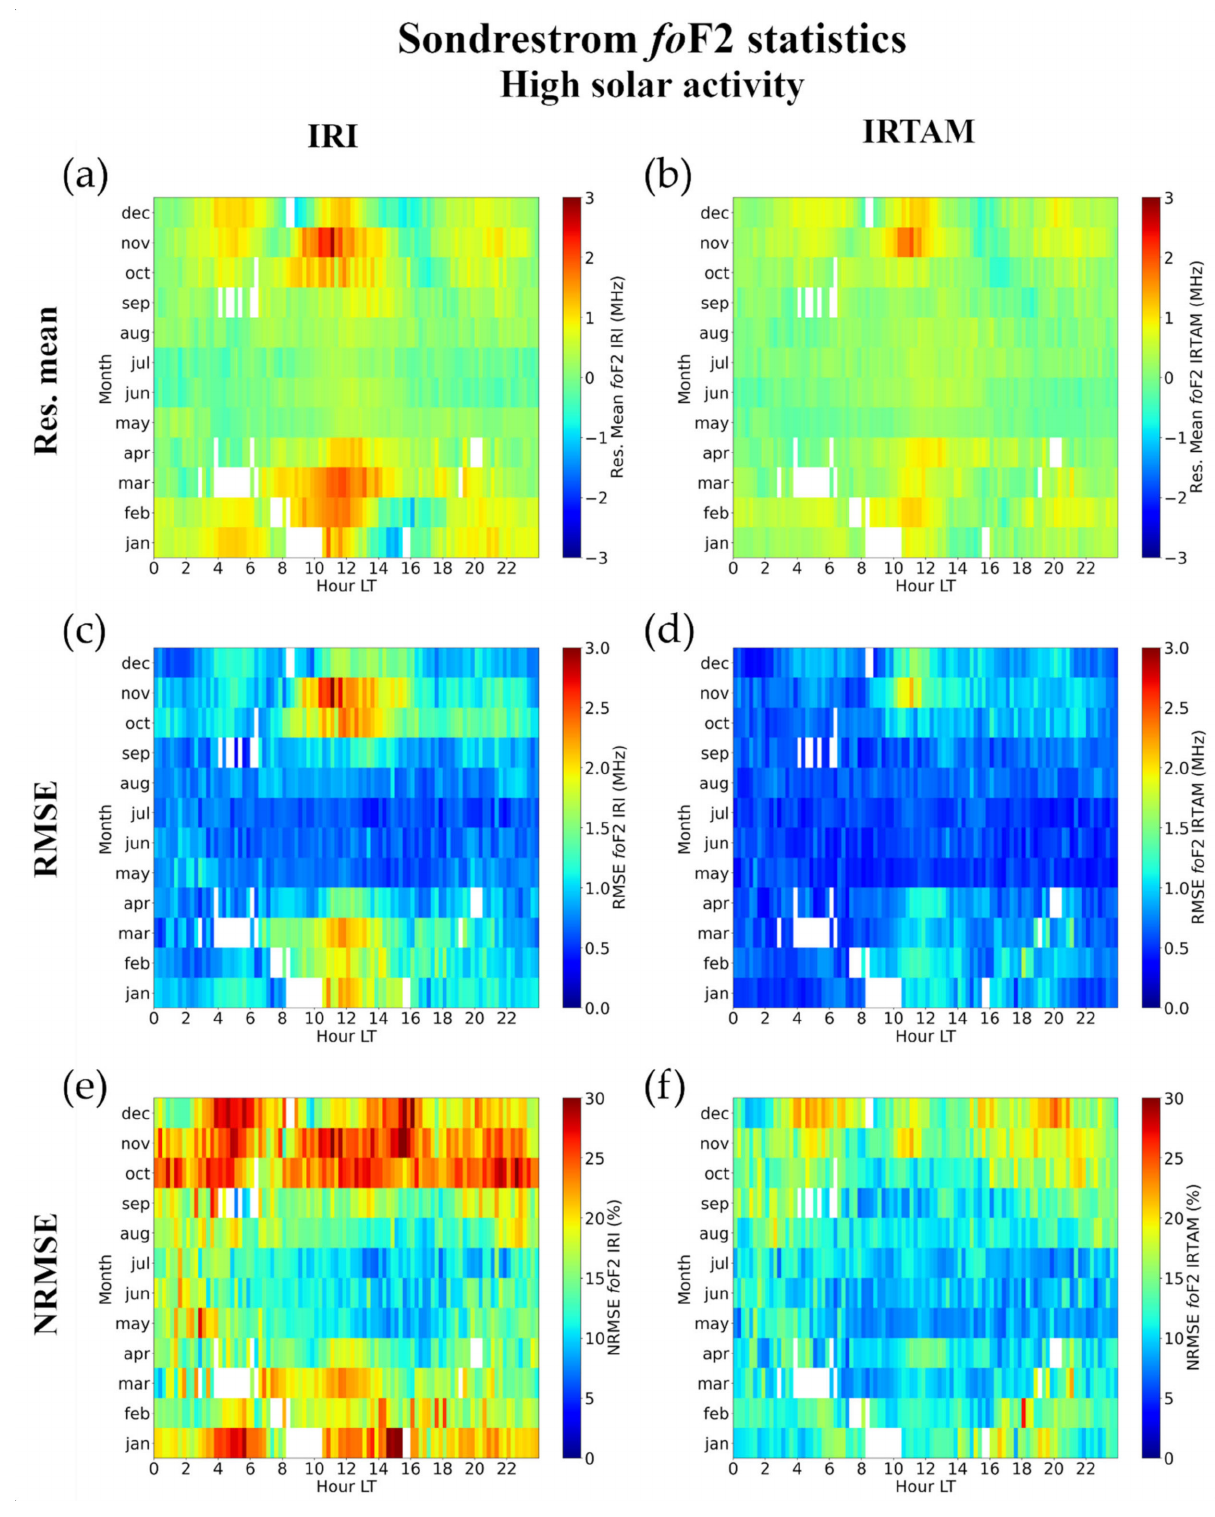
Figure 15. Same as Figure 13 but for HSA